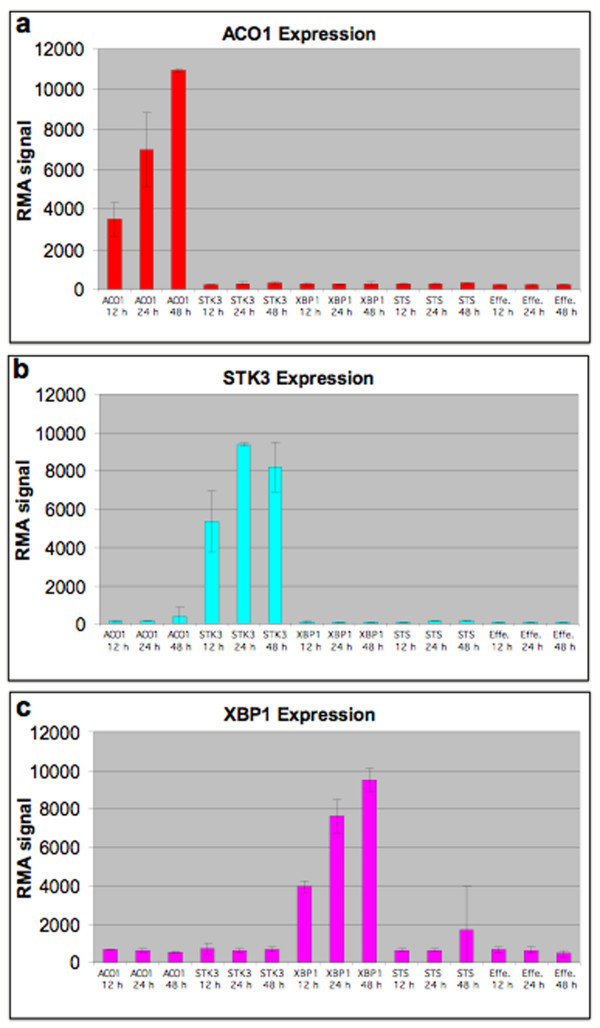
ACO1, STK3 and XBP1 expression following transfection in six-well plates. ACO1, STK3 and XBP1 probe set RMA normalised signal intensities were plotted over the time course for each combined sample. Results for replicate samples were averaged, error bars indicate the individual replicate measurements.